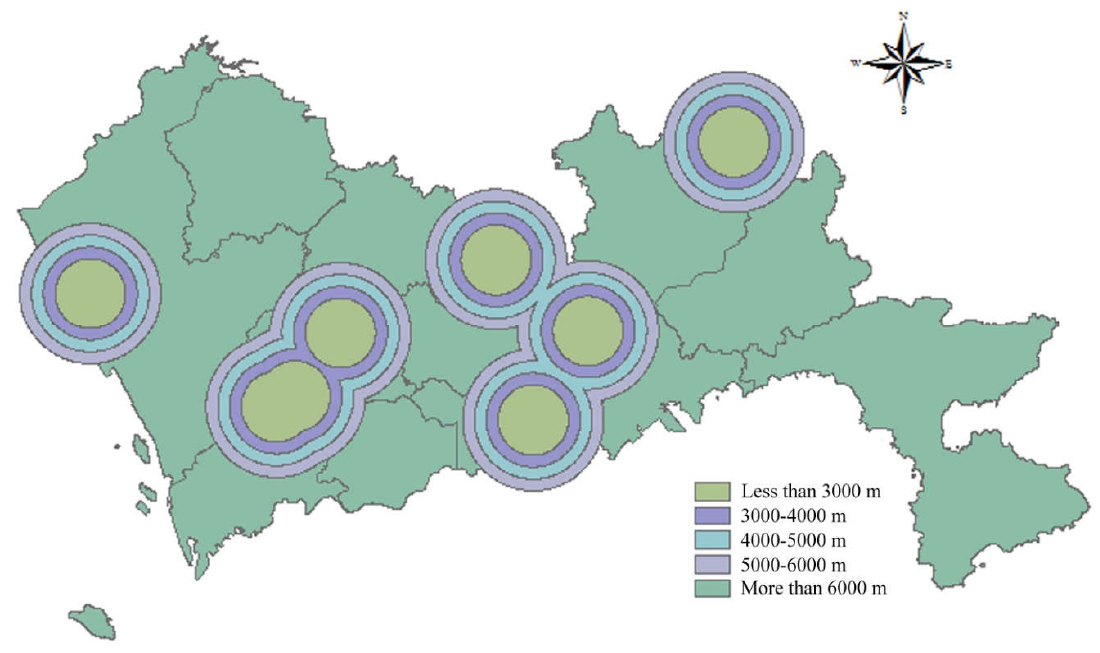
Figure 4. Map of distance to airport.